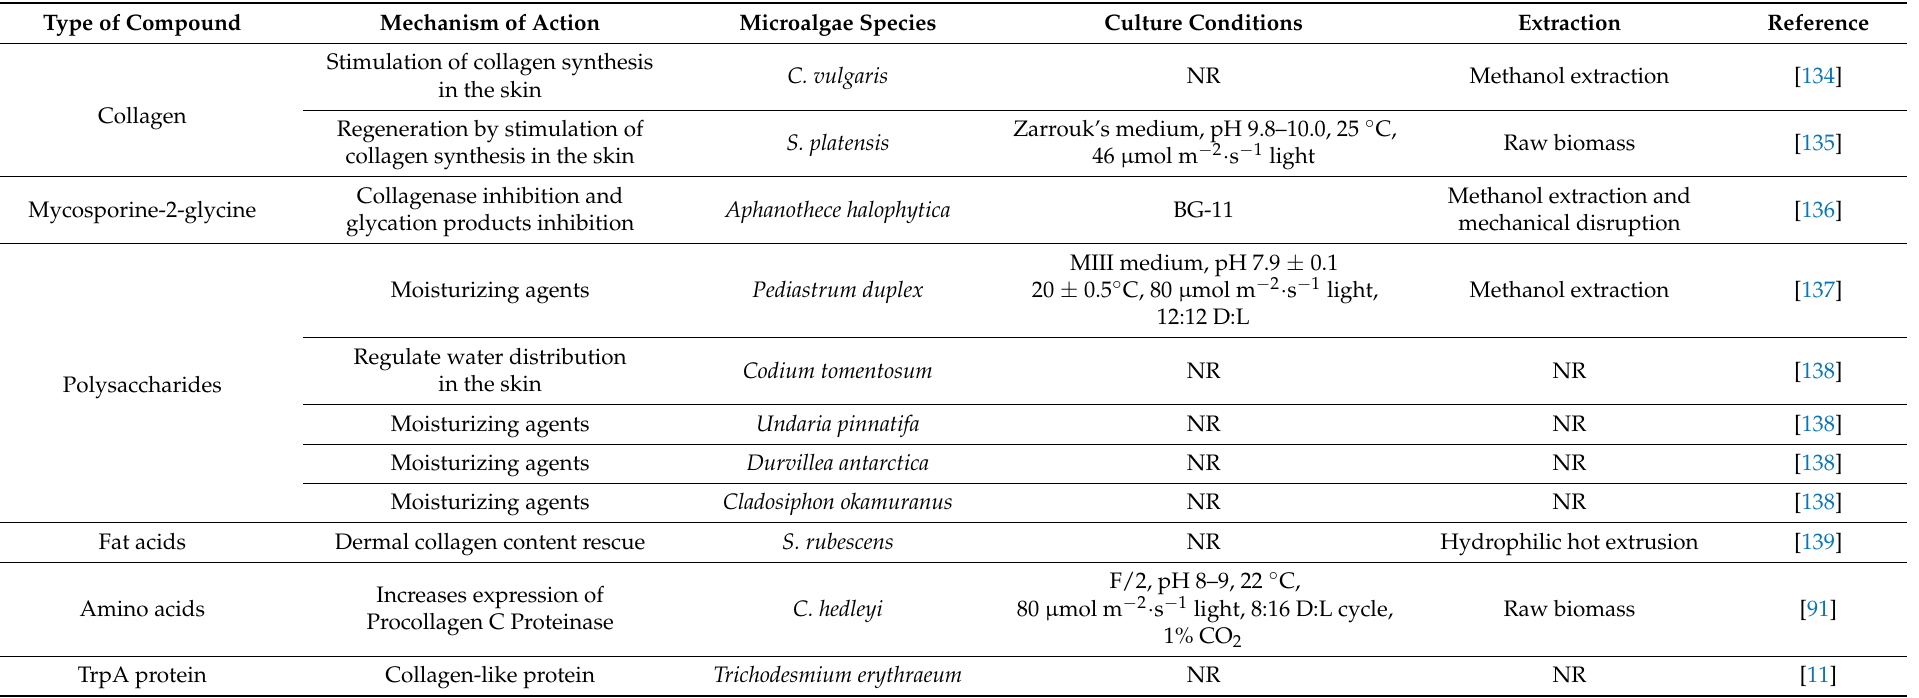
Table 4. List of compounds with moisturizing and regenerative activity obtained from